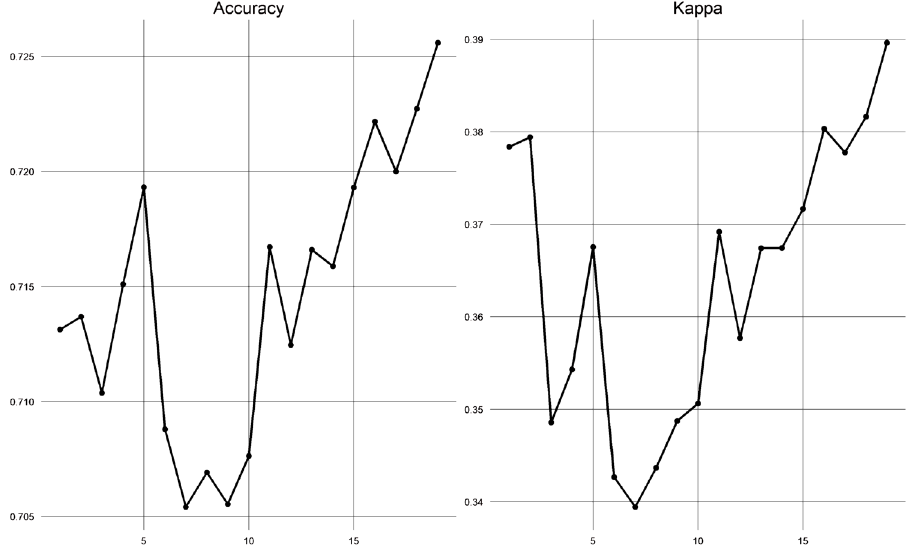
Figure 4. The performance following the number of variables obtained from the RF-RFE method.